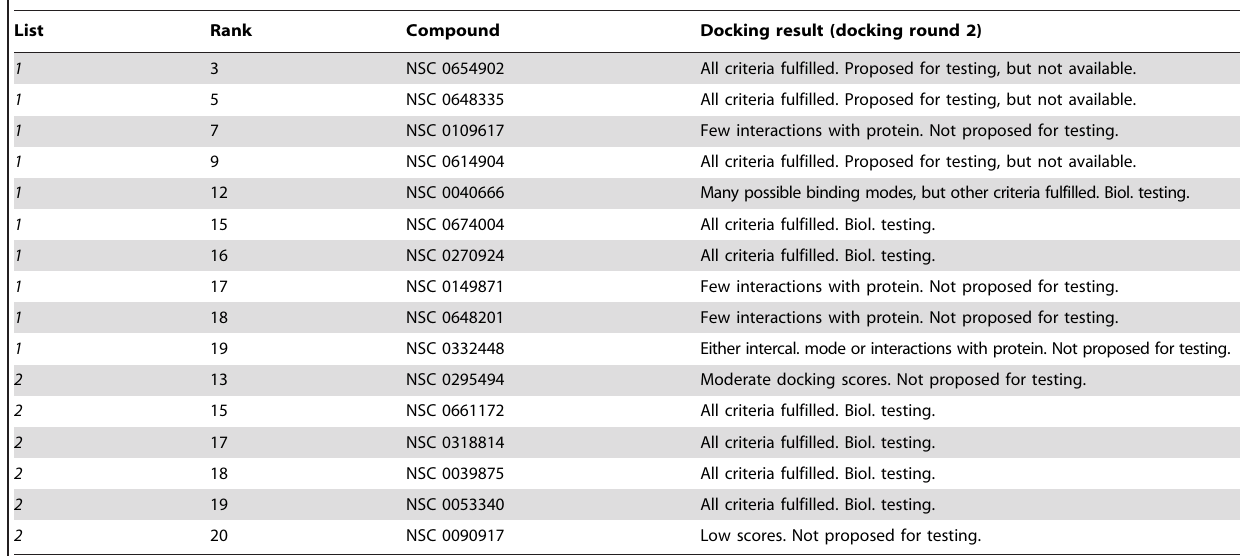
Table 2. Compounds that have passed into the second docking round.